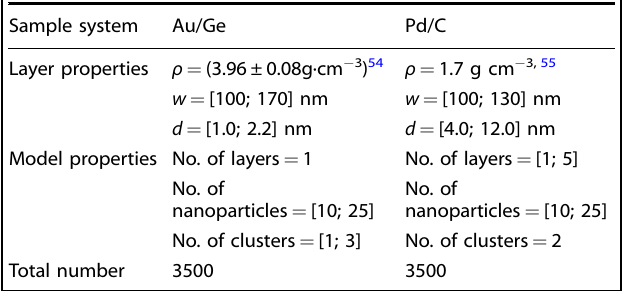
Table 3. Aberrations and resulting dataset size used in simulated training